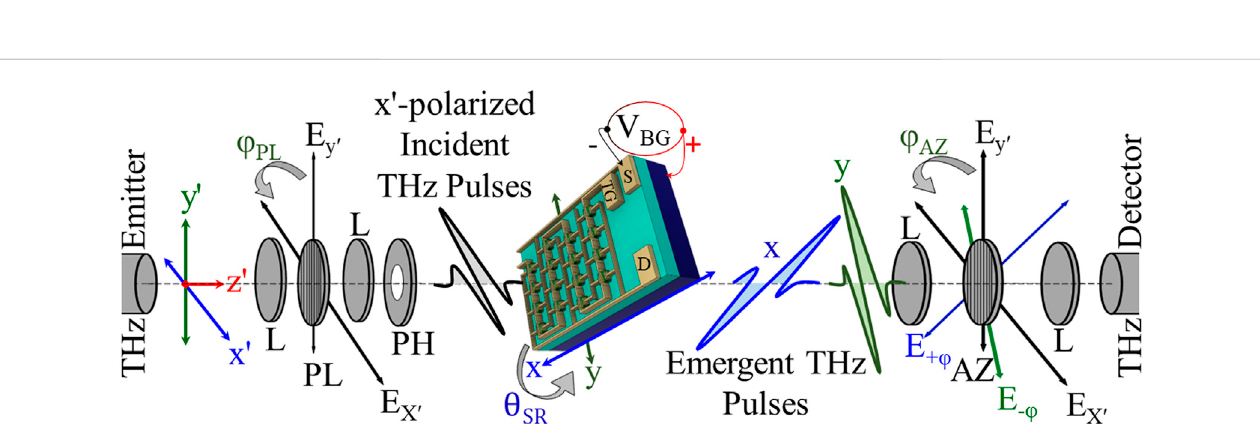
FIGURE 3 Schematic view of the THz time domain setup (THz-TDS) where the THz emitter and detector are horizontally polarized along the x ’ axis. θ SR and ϕ are rotational angles with respect to x ’ and y ’ axes, respectively. L: lenses, PL: polarizer, PH: pinhole (Iris), V GND : ground connection that is always in contact with the graphene patches through the source and drain pads, V BG : top- or back-gates terminal, and AZ: